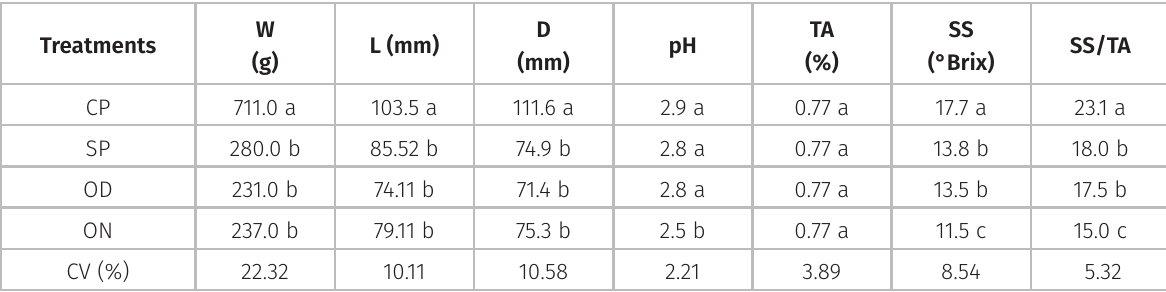
Table IV. Fruit weight (W), length (L), diameter (D), pH, titratable acidity (TA), soluble solids (SS), and SS/TA ratio. Pollinations performed on 03/04/20. Treatments: cross-pollination (CP), self-pollination (SP), diurnal open pollination (OD), and nocturnal open pollination